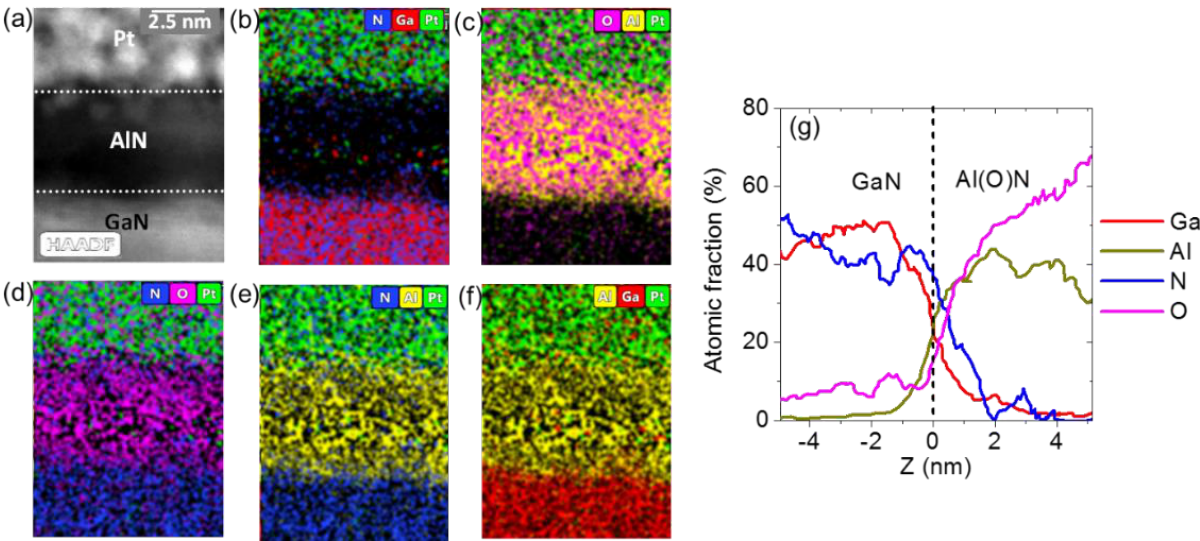
Figure 2. ( a ) Cross-sectional HAADF-STEM image of the 5 nm AlN film on GaN. ( b – f ) Corresponding EDS chemical maps of Ga, N, Al, O and Pt, shown with different elemental combinations, from which the distribution of the different species in the analyzed stack can be clearly deduced. ( g ) EDS scan lines of the percent atomic concentrations for the Ga, N, Al and O species.